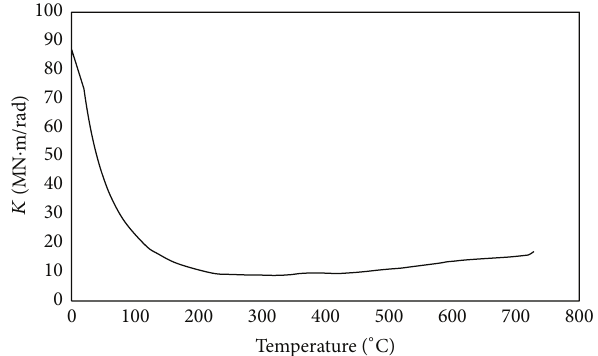
Figure 24: Diagram of stiffness: temperature for the connection bolted cover plate.